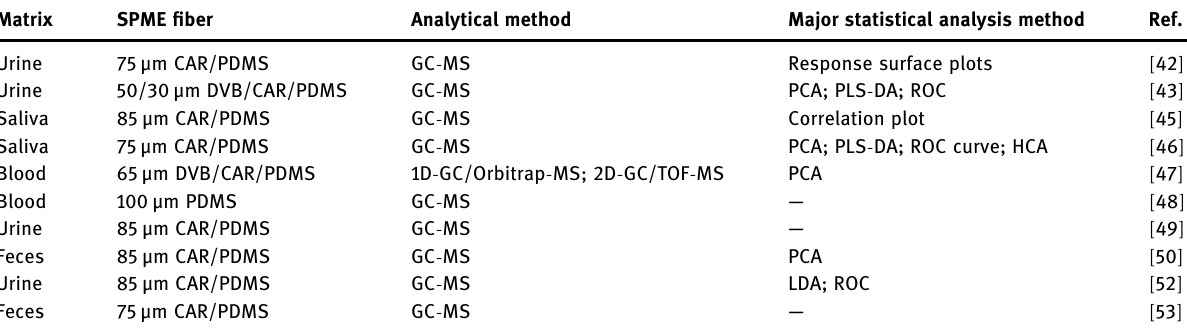
Table 2: Selected reports using the HS - SPME to investigate volatile metabolomics in human biological matrices Matrix SPME fi